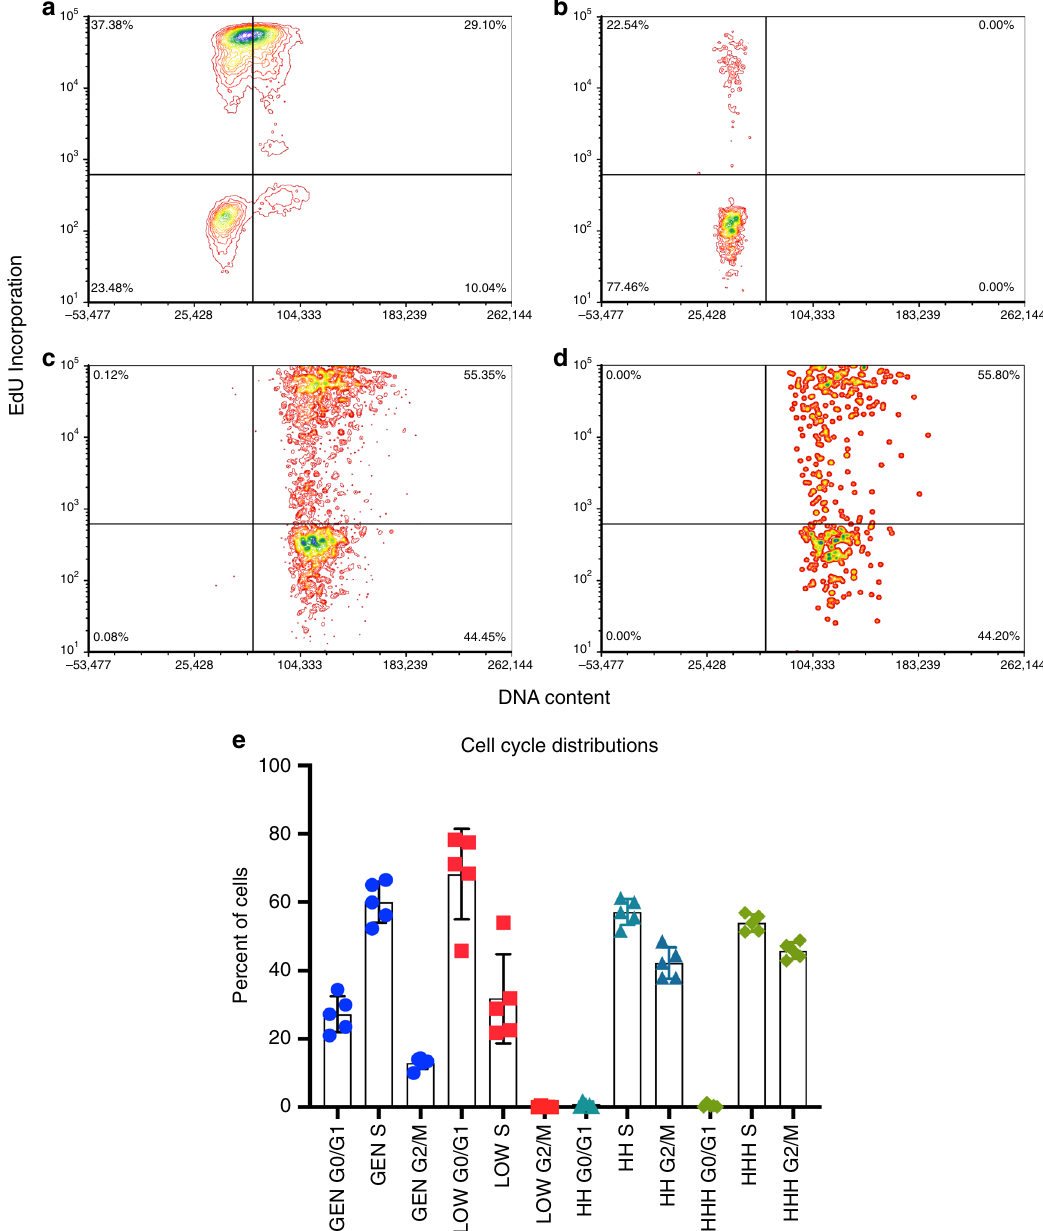
Fig. 3 Cell cycle analysis of hPSC subpopulations by fl ow cytometry of EdU labeled cultures. Cells were pulsed labeled with EdU, sorted into three subpopulations using cell surface markers GCTM-2 and CD9 with or without EPCAM, and analyzed by fl ow cytometry. a – d Flow cytometry pro fi les from one experiment. a Unsorted population; b GCTM-2 low CD9 low ; c GCTM-2 high CD9 high ; d GCTM-2 high CD9 high EPCAM high ; e summary showing results from seven experiments. Mean values are shown and error bars represent standard error of seven biological replicates; General is unsorted population, low is GCTM-2 low CD9 low , HH is GCTM-2 high CD9 high , and HHH is GCTM-2 high CD9 high EPCAM high . See Supplementary Table 6 for biological replicate data